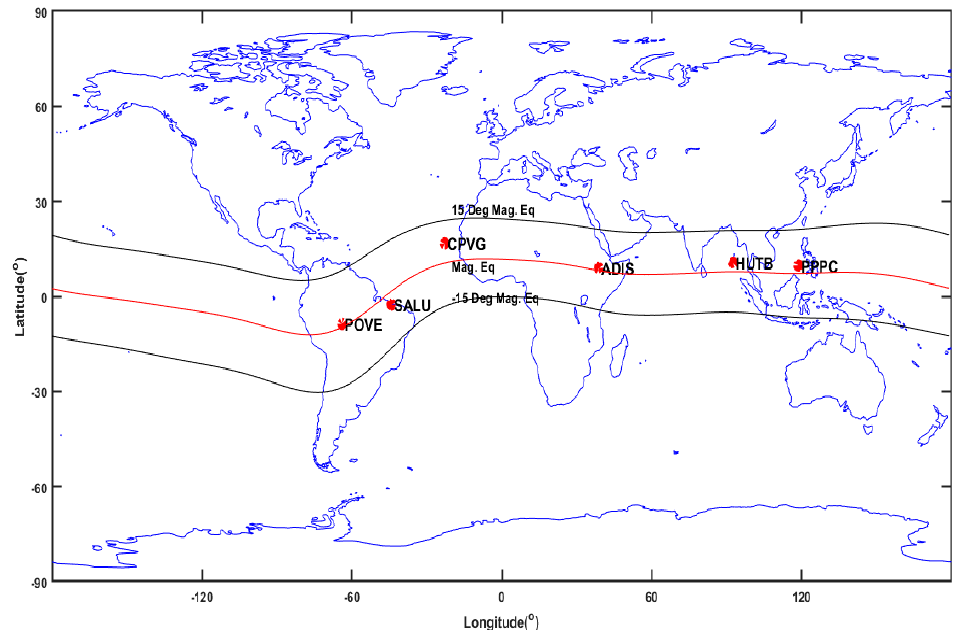
Figure 1. Location of GPS stations at different longitude sectors considered in this study, a red contour line in the center of the map indicates the magnetic equator, whereas the black counters in either hemisphere represent the approximate position of the EIA crest during the period. The red colour stars indicate the locations of GPS stations as listed in Table 1.